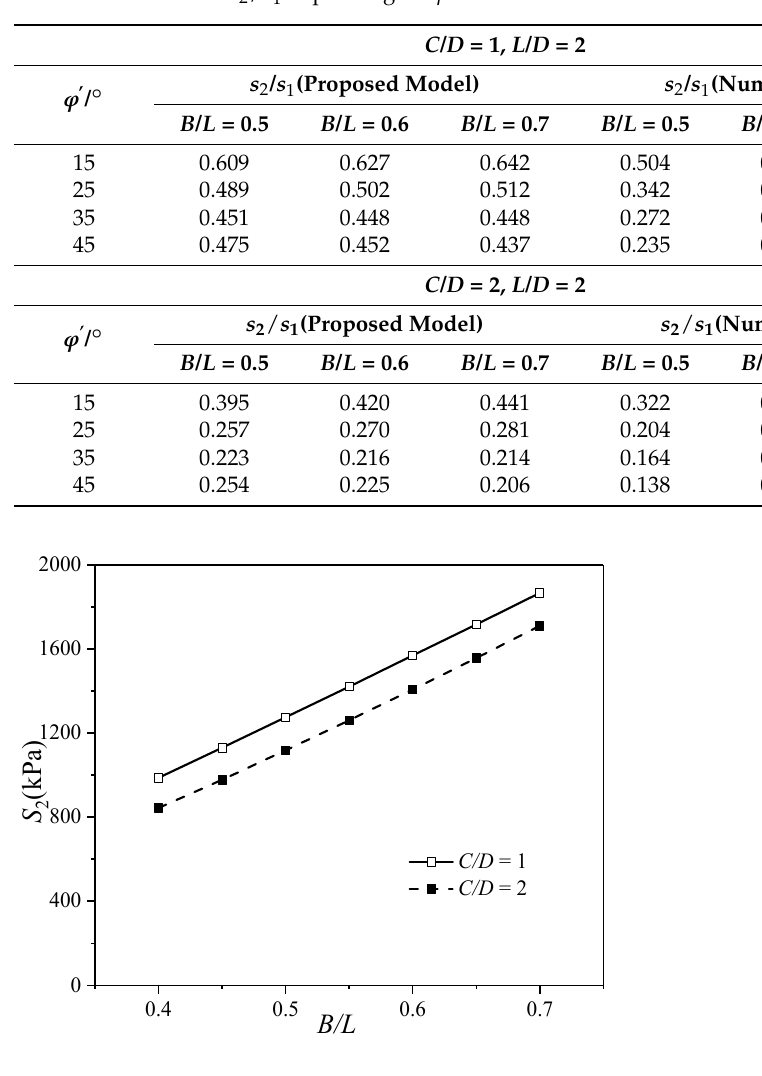
Table 2. Variations in s 2 / s 1 depending on ϕ (cid:48) .